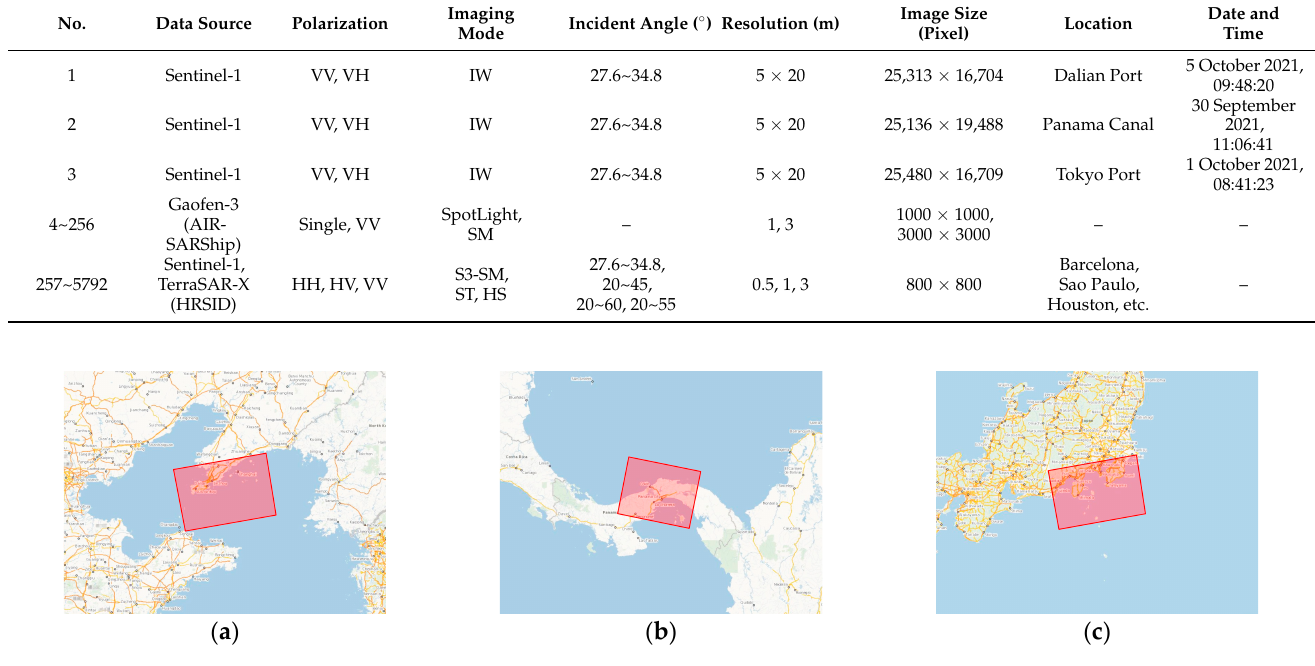
Figure 13. Coverage areas of No. 1–3 Sentinel-1 images. ( a ) The Dalian Port; ( b ) the Panama Canal; ( c ) the Tokyo Port. Table 2. Detailed information of the original SAR imageries used to establish our RSSD.